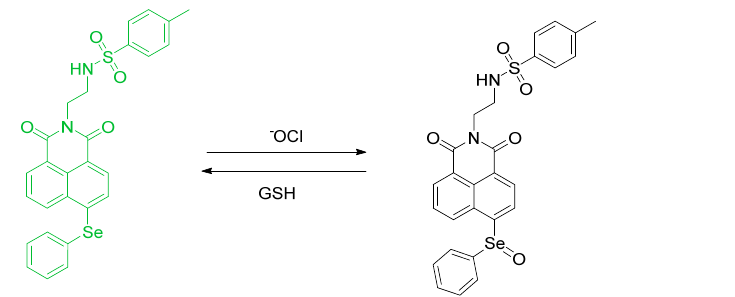
Figure 16. The structure and reactivity of the reversible/reserrable Se–Ph containing species reported by Zang et al.